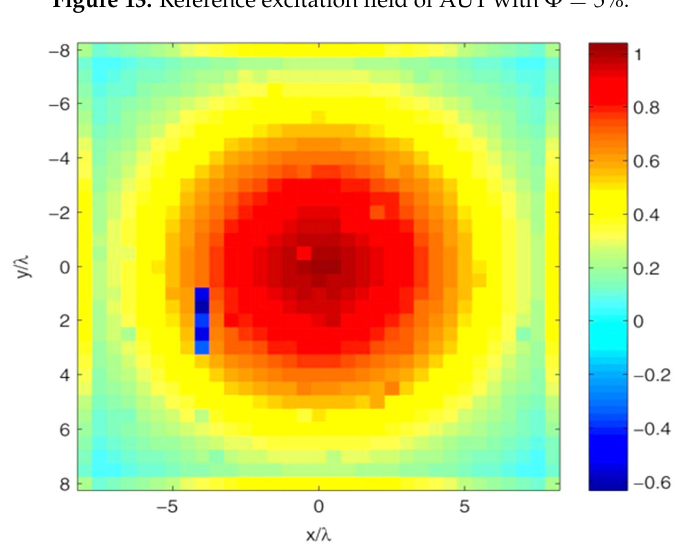
Figure 14. AUT with K = 5 failures Φ = 5%: reconstructed excitation error field by 30 random noisy measurement points. Electronics 2018 , 7 , x FOR PEER REVIEW